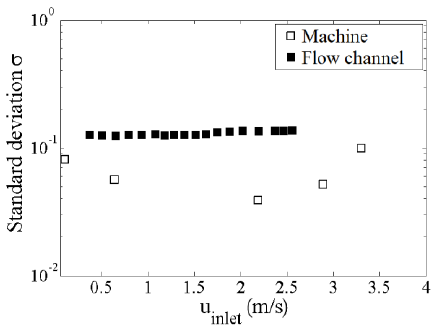
Figure 8. Standard deviation between measured spectra in the test flow channel and the spectra measured in a working machine at various inlet velocities.